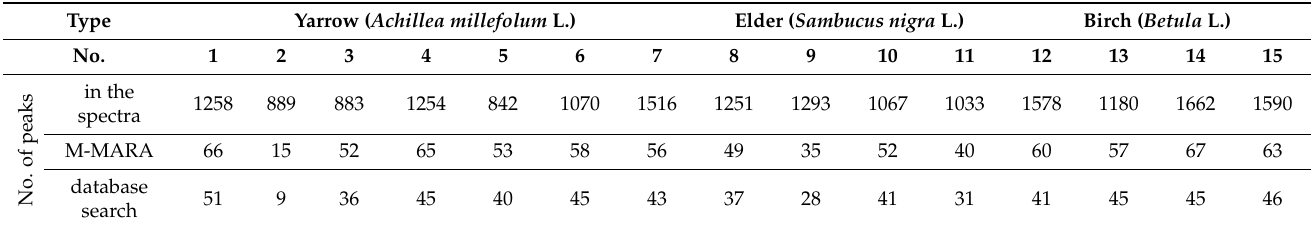
Table 1. The number of m/z peaks in the ESI-DIMS spectra of herb extracts before and after M-MARA filtering, and identified by database search. Type Yarrow ( Achillea millefolum L.) Elder ( Sambucus nigra L.) Birch ( Betula